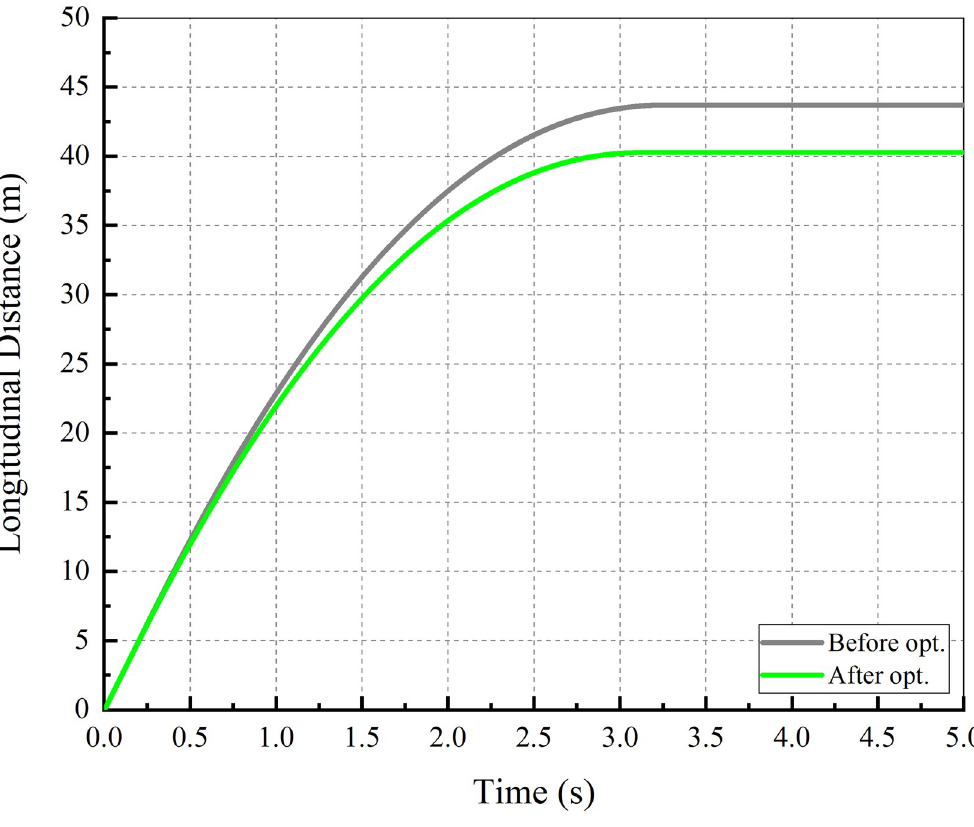
Fig 17. Longitudinal